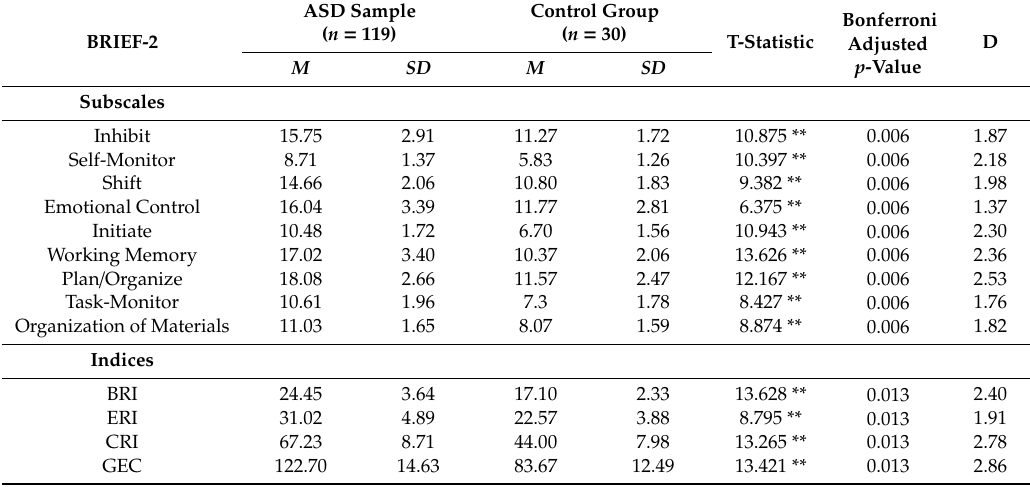
Table 5. Comparing the ASD and typically developing (TD) Groups Based on the BRIEF-2 Scales.